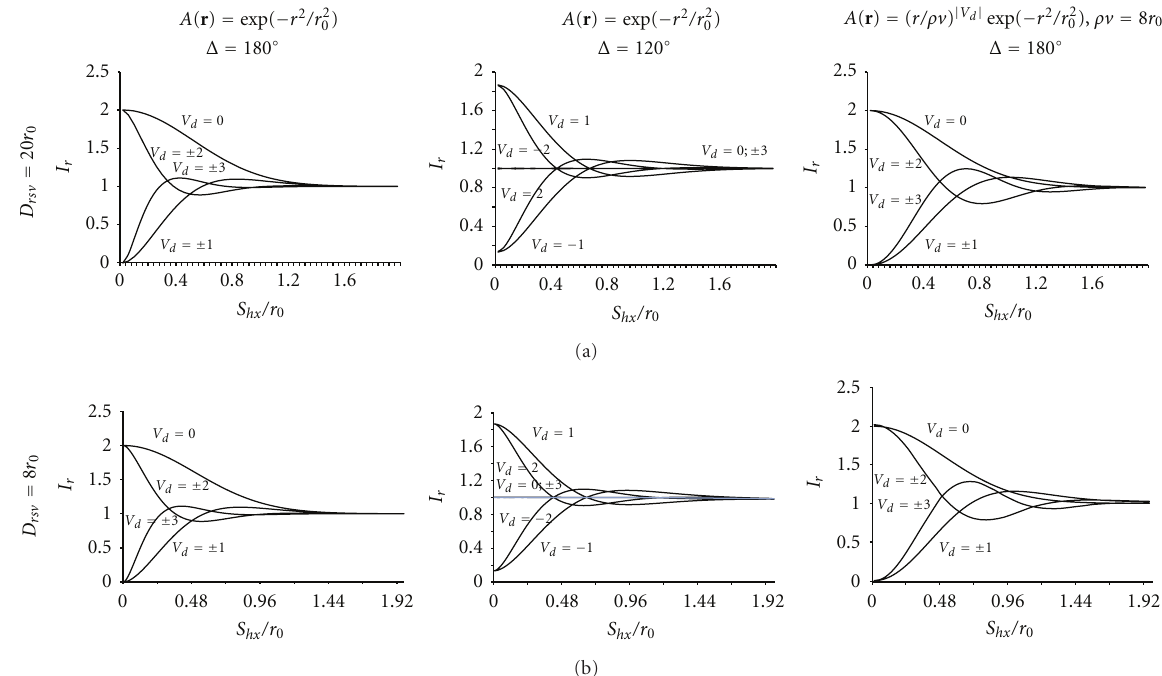
Figure 5: Dependence of relative intensity of interference field I r ( S hx /r 0 ) on the shift of optical axes S hx obtained for di ff erent initial amplitude profiles, angles of rotation Δ , and topological charges V d